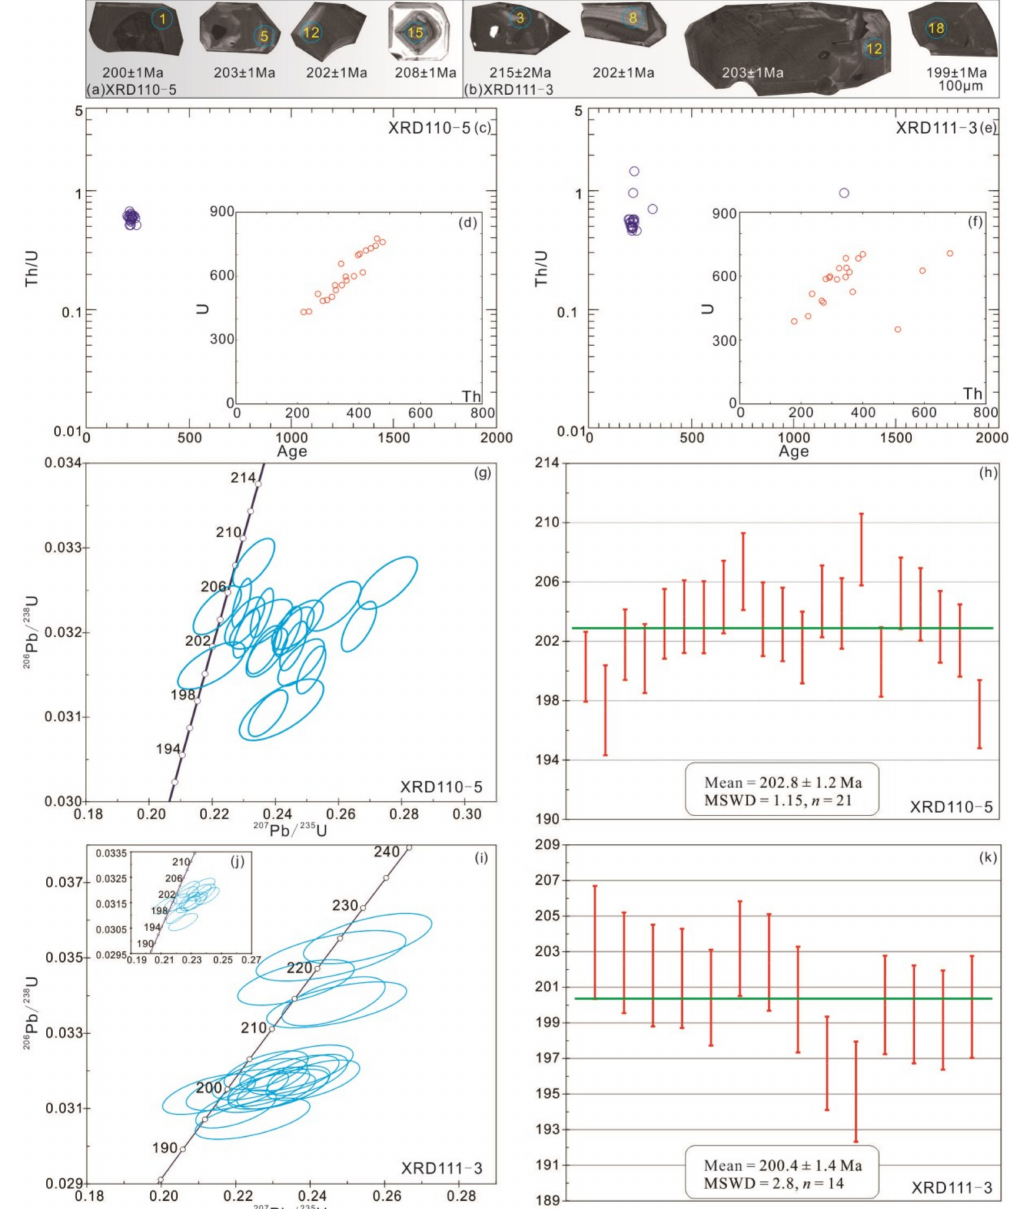
Figure 5. ( a , b ) CL images and single-zircon 206 Pb/ 238 U ages of zircons; ( c ) Th/U vs. age of zircon diagram of sample XRD110-5; ( d ) Th vs. U content of zircon diagram of sample XRD110-5; ( e ) Th/U vs. age of zircon diagram of sample XRD111-3; ( f ) Th vs. U content of zircon diagram of sample XRD111-3; ( g – h ) LA-ICP-MS zircon U-Pb concordia diagram of sample XRD110-5; ( i – k ) LA-ICP-MS zircon U-Pb concordia diagram of sample XRD111-3 of the Keri rhyolites in the EKOB. The 206 Pb/ 238 U and 207 Pb/ 235 U at 21 measurement points of the sample